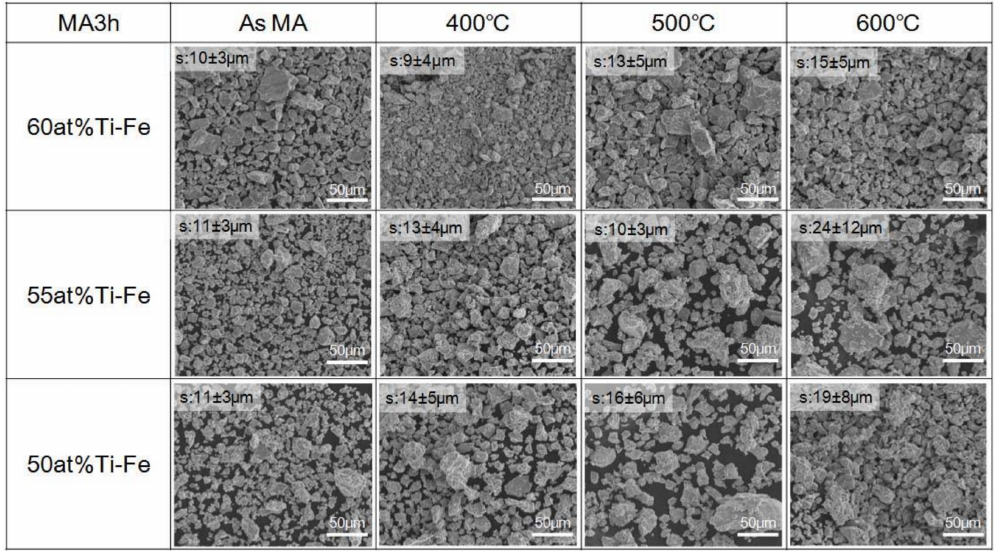
Figure 3. SEM images of 3 h MA samples with different Ti-contents after heat treatment at several temperatures.